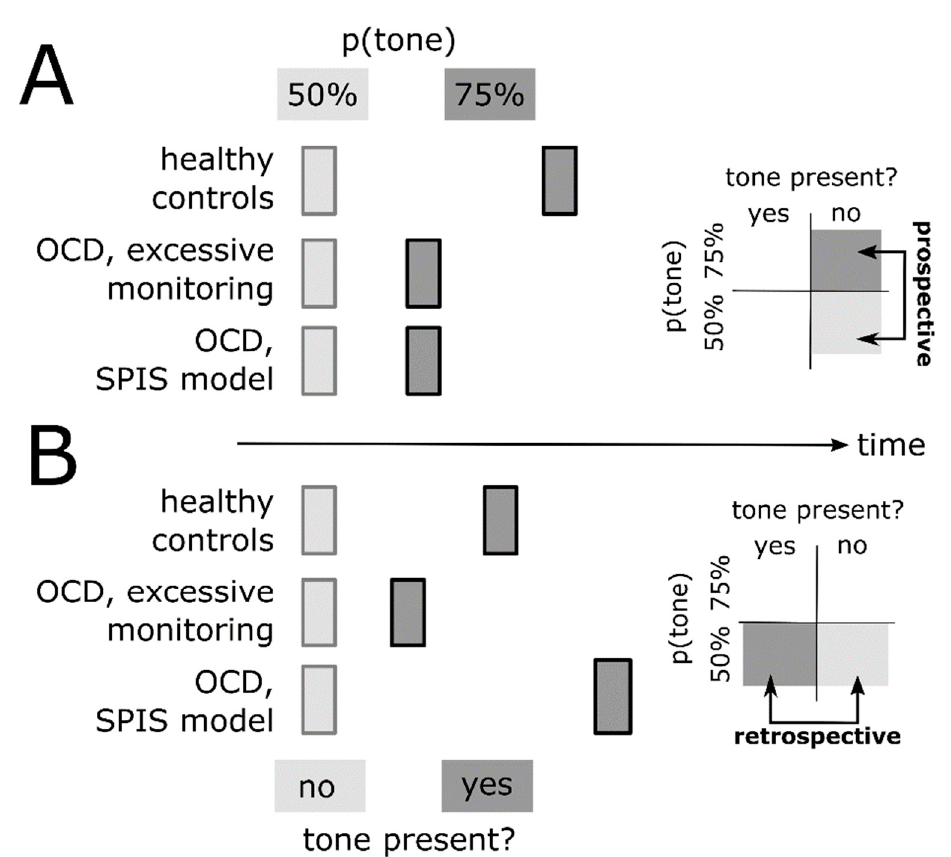
Figure 3. Prospective ( A ) and retrospective ( B ) components of intentional binding of action in healthy individuals ( top row ) and patients with OCD, under the assumption of excessive conscious monitoring of action ( middle row ) and the SPIS model ( bottom row ). Insets on the right represent contrasts used to isolate prospective and retrospective binding, respectively. In ( A ), the perceived time of action in the 50% tone probability condition (light grey) is aligned in time (x-axis) across groups (healthy controls vs. OCD) to illustrate group differences in a predictive (prospective) shift of the perceived time of action in the 75% tone probability condition (dark grey). In ( B ), the perceived time of action in the 50% tone probability condition without actual tone presentation (light grey) is aligned in time across groups to illustrate group differences in a retrospective shift of the perceived time of action in the 50% tone probability condition with actual tone presentation (dark grey).